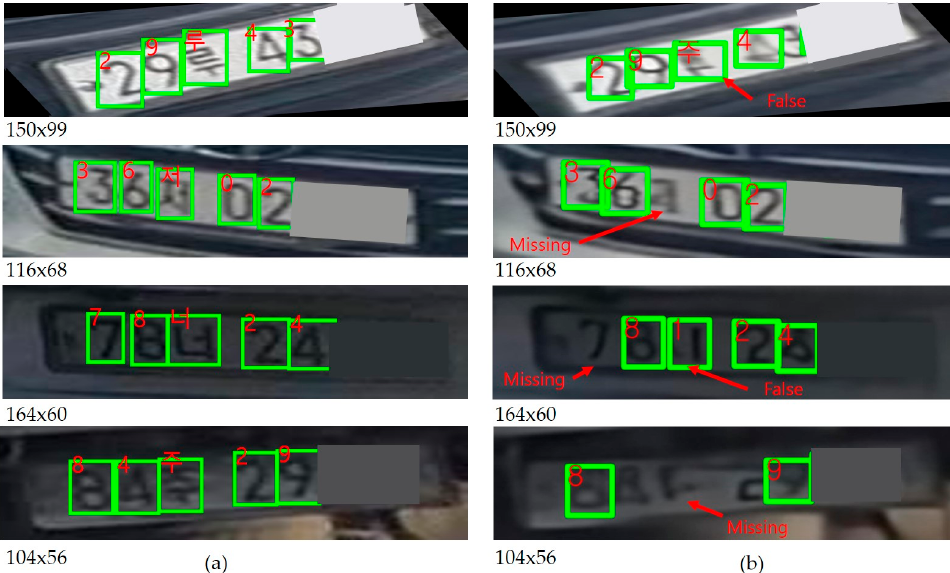
Figure 13. Examples of character recognition results. Recognition results on ( a ) bicubic results (4×), ( b ) proposed SR results (4×), and ( c ) HR images. Two characters were masked due to privacy poli- cies.